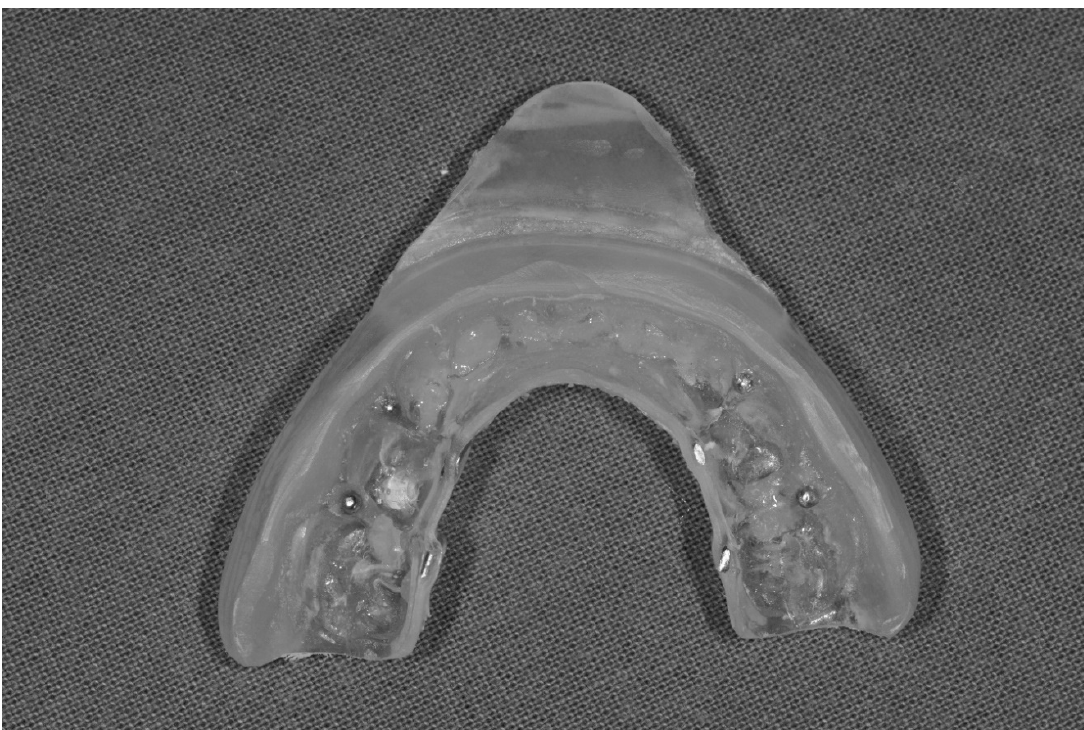
Figure 6. Modified bite.